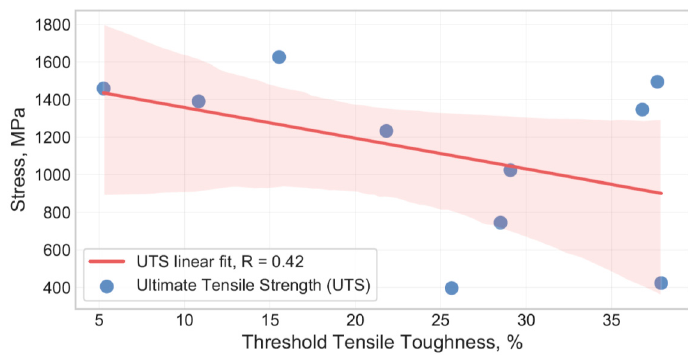
Figure 8. Threshold tensile toughness ( ( K IH · 100 ) /K Ic ) as a function of the ultimate tensile strength (UTS) calculated for the studied steels. Translucent bands around the regression line define the confidence interval of the regression.